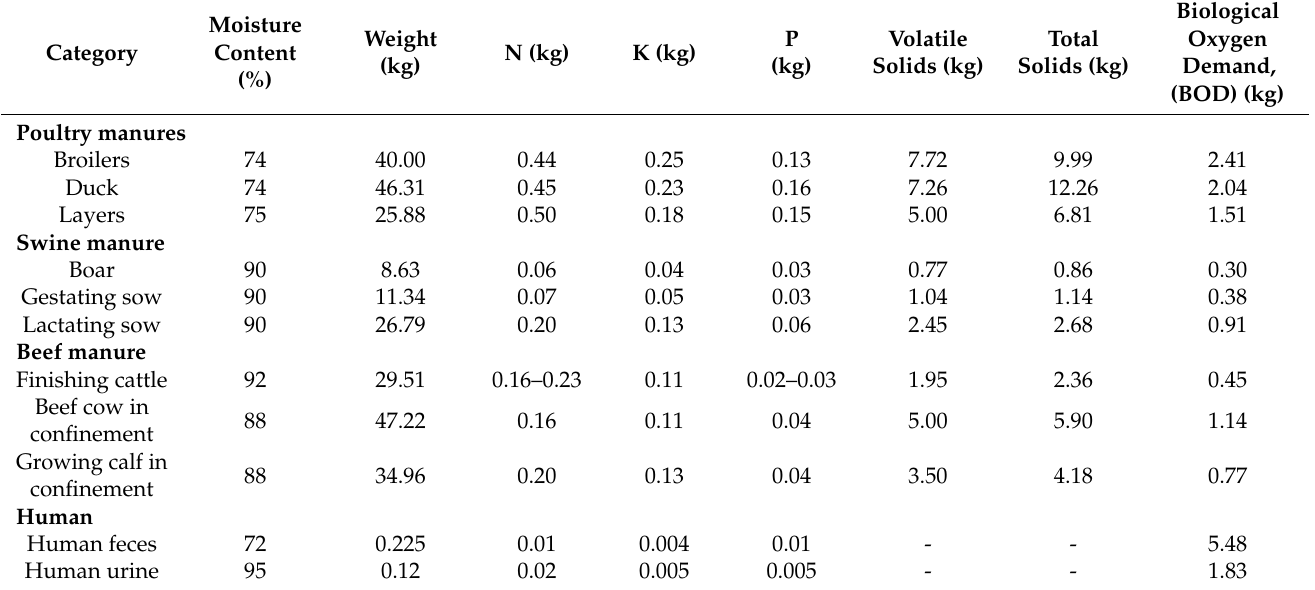
Table 2. Composition and nutrient content of animal manure and human excreta